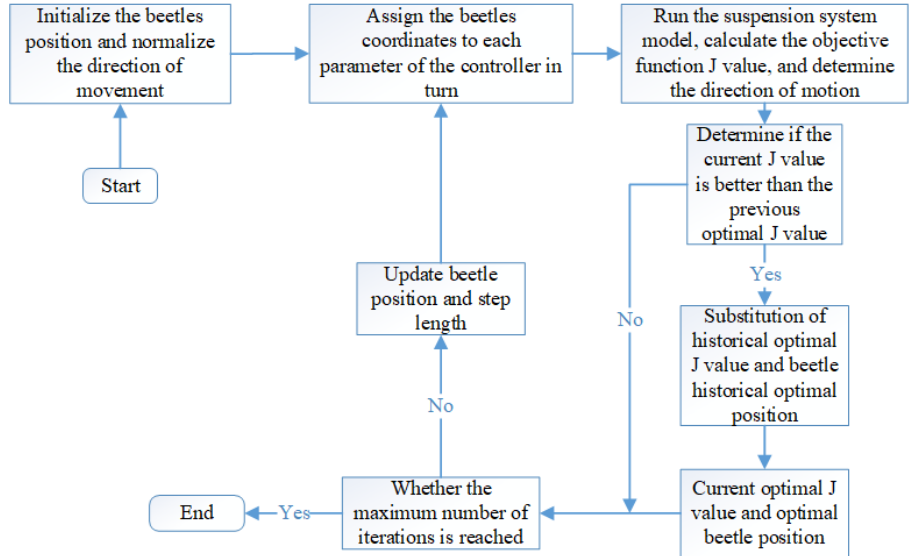
Figure 13. shows a flow chart of PID and fractional order PID parameter adjustment using the Beetle Antenna Search algorithm.